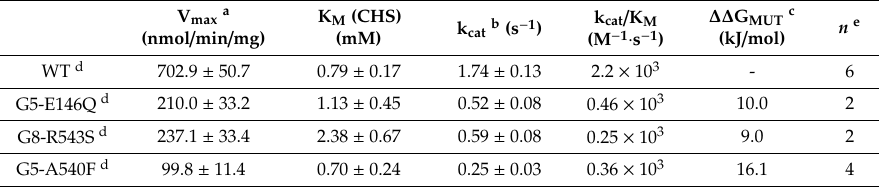
Table 2. Dependence of ABCG5 / G8 ATPase activity on cholesteryl